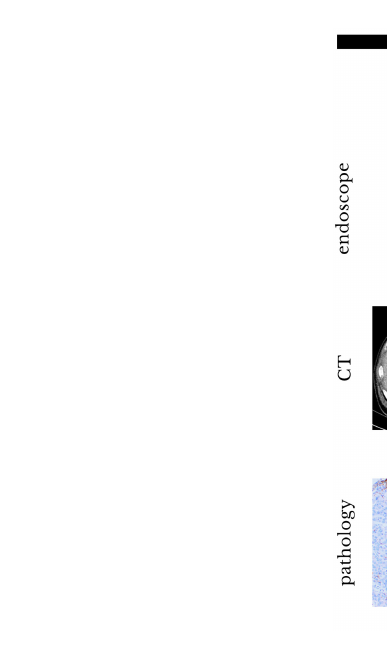
FIGURE 3 | Case presentation of case 2. CCRT, concurrent radiotherapy; CR, complete remission; CT, computed tomography; PR, partial remission; SD, stable disease; T, tumor; TC, paclitaxel/carboplatin; TP,